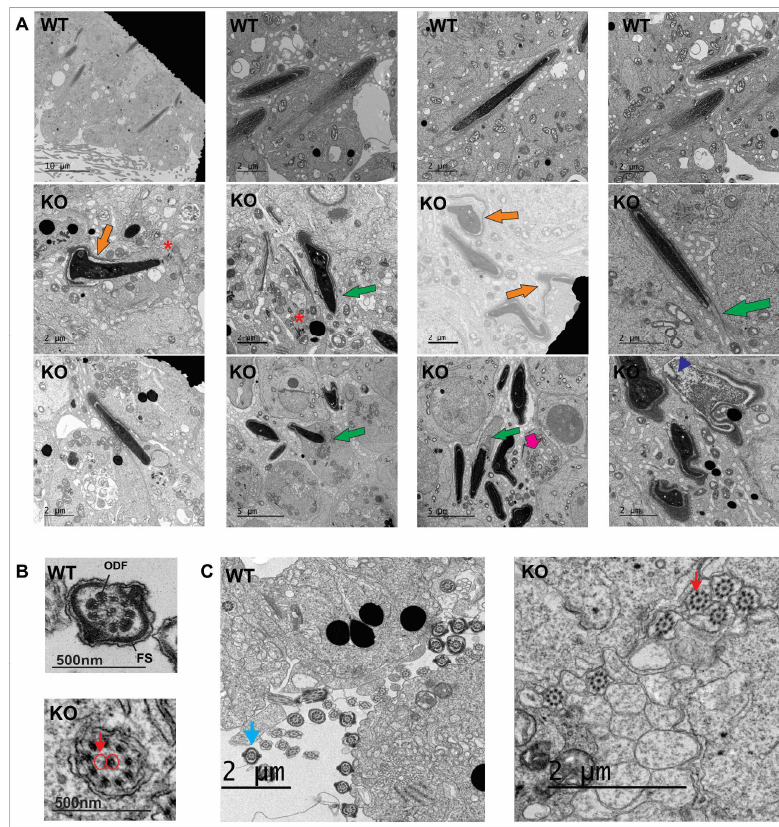
Figure 7 Figure 7. Structural analysis of elongating spermatids by TEM. ( A ) Wild-type elongating spermatids show normal assembly of the manchette and chromatin condensation. The morphology of the head and acrosome develops normally as well. Elongating spermatids from knockout mice have several defects. The manchette structure is disorganized (green arrows) or absent. Chromatin condensation is affected (blue arrowhead) as well as the nucleus and acrosome shapes. The orange arrows show detached acrosomes; * shows dispersed outer dense fiber material. The pink arrows show disorganized mitochondria. ( B ) TEM microscopy from testis samples shows some axonemes missing one CP microtubule (9 + 1) indicated by the red arrow; however, the majority of the axonemes show the 9 + 2 arrangement of their microtubules. ( C ) Fibrous sheath and outer dense fibers were observed in the wild-type testis (the blue arrow points to a representative flagellum showing these structures). However, these structures were not observed around the axoneme in the knockout flagella. Red arrow indicate 9 + 1 axoneme. WT, wild-type; KO, knockout; ODF, outer dense fibers; FS, fibrous